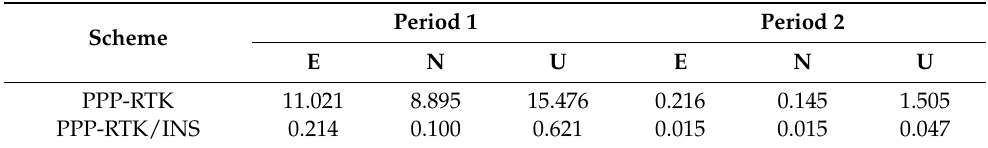
Table 3. Positioning accuracy of PPP-RTK and TC PPP-RTK/INS in different periods in experiment A (unit: m).